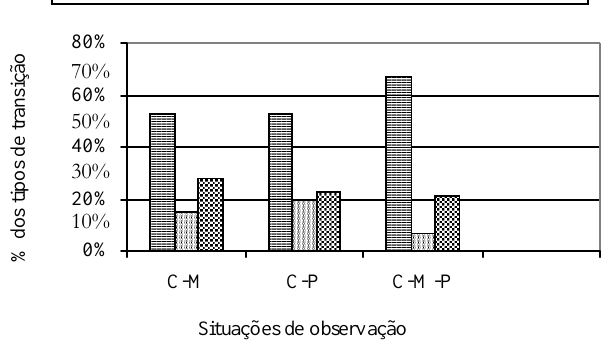
Figura 3. Tipos de transi(cid:231)ªo de uma atividade para outra, por situa(cid:231)ªo de observa(cid:231)ªo.